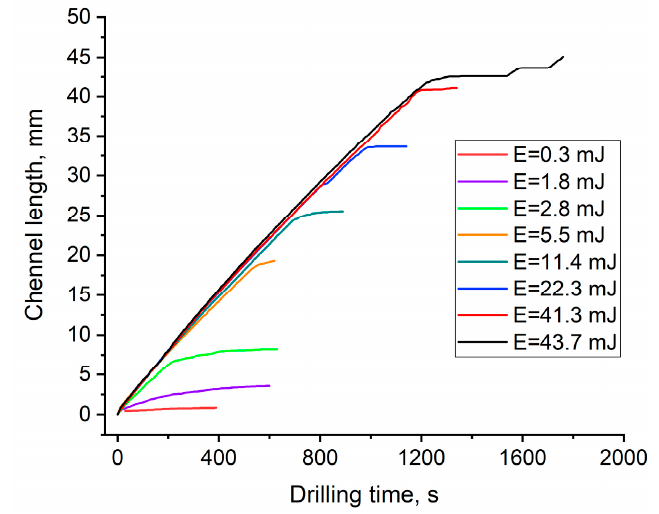
Figure 6. Channel length z vs. drilling time t for various pulse energies at a 10 Hz rep rate.